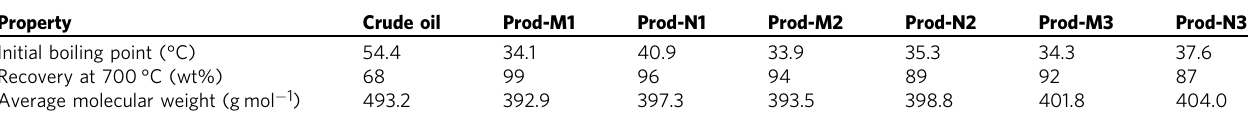
Table 1 Typical SDA results for crude oil and upgrading products over catalysts with different reaction cycles under methane and